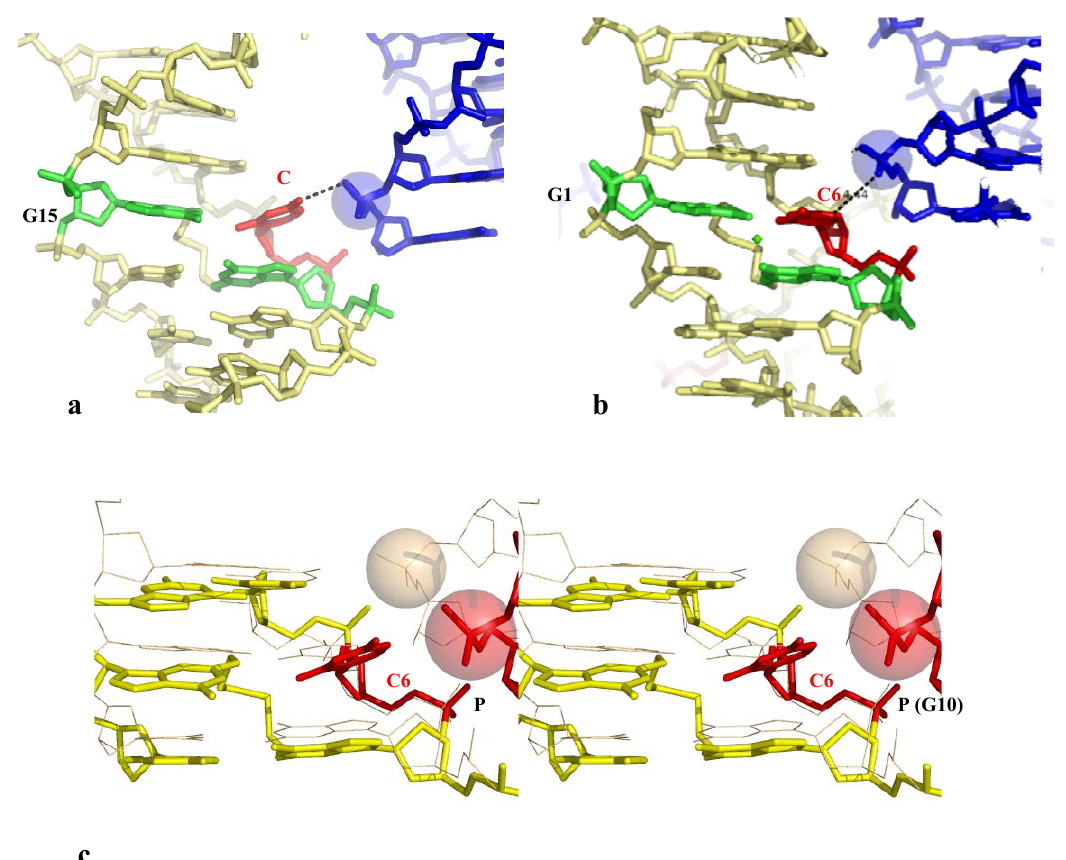
Figure 3. Direct Base pair opening induced by DNA-DNA interactions. ( a ) The open form of the decamer d(CCAGGCCTGG) (the G denotes the crosslinked G); ( b ) The closed form of the same decamer. The flipped out cytosine in the open form and the corresponding one in the closed one, are represented in red; ( c ) Stereo view of the superimposition of the open (yellow, thick line) and closed (wheat, thin line) forms with their symmetry related molecule. The opening phosphate group is represented in